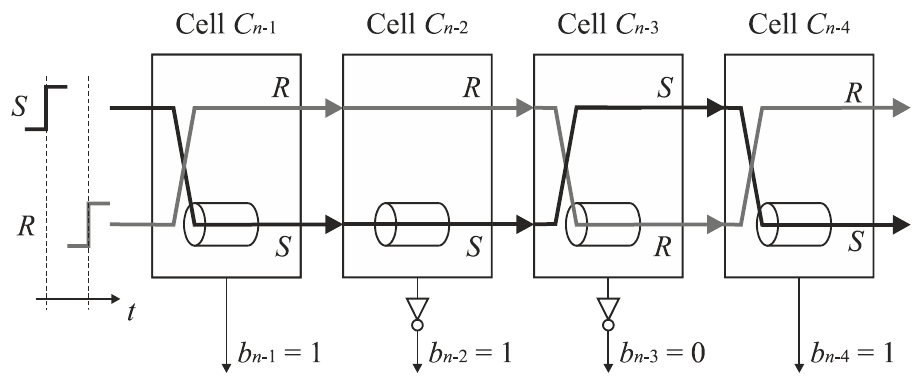
Figure 17. Propagation of signals S and R in n -bit feedforward SA-TDC with single set of delay lines without output switches.